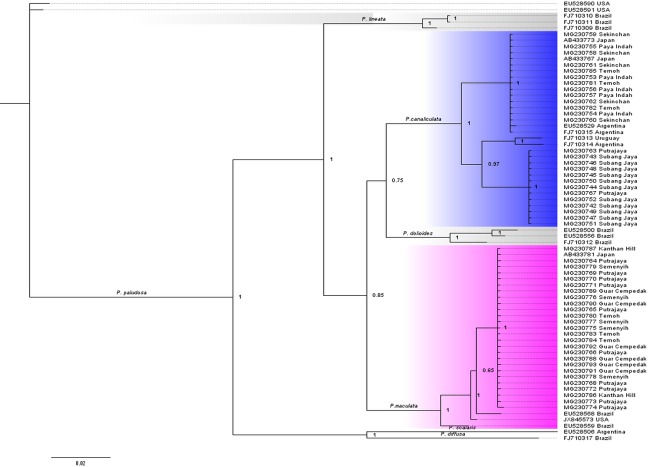
Phylogram shows BI analysis of Pomacea canaliculata and P. maculata in Peninsular Malaysia with other Pomacea species from introduced (USA, Japan) and native (South America) ranges.Bayesian posterior probabilities are shown for each clade. Pomacea scalaris and Pomacea diffusa were selected to root the tree. Only nodes with Bayesian posterior probabilities (PP) greater than 0.5 as a validity supported clade for the construction of a 50% majority rule consensus tree.